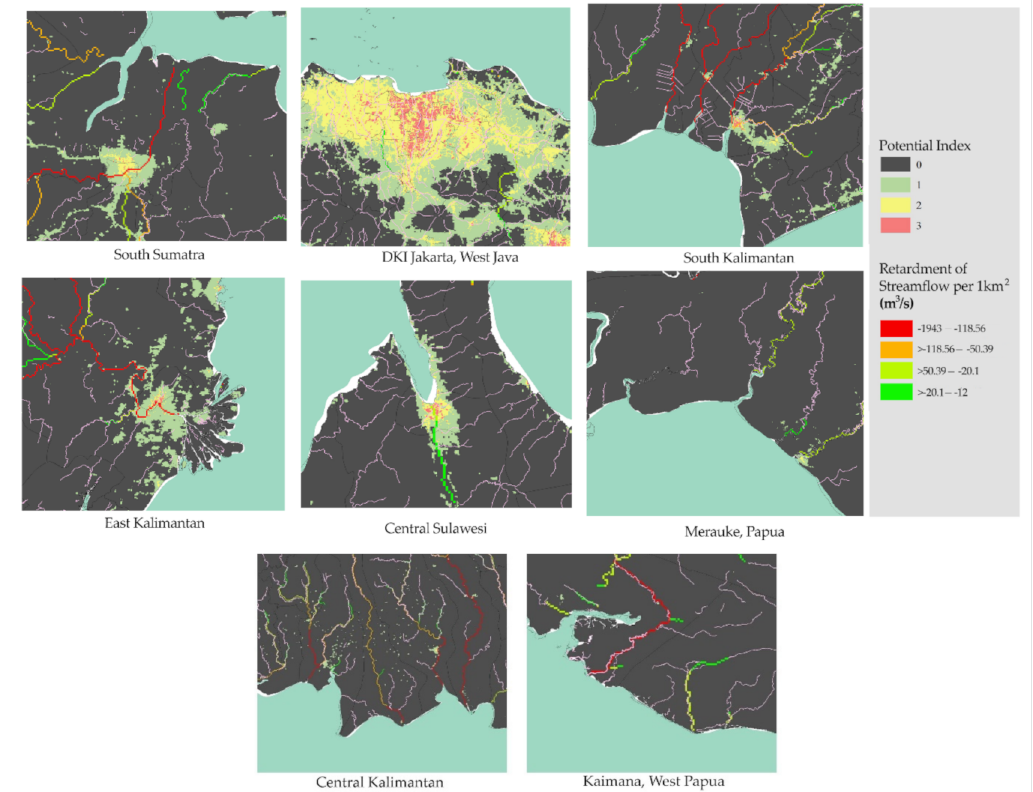
Figure 14. A comparison between FLO1K [42] products of annual streamflow through the potential